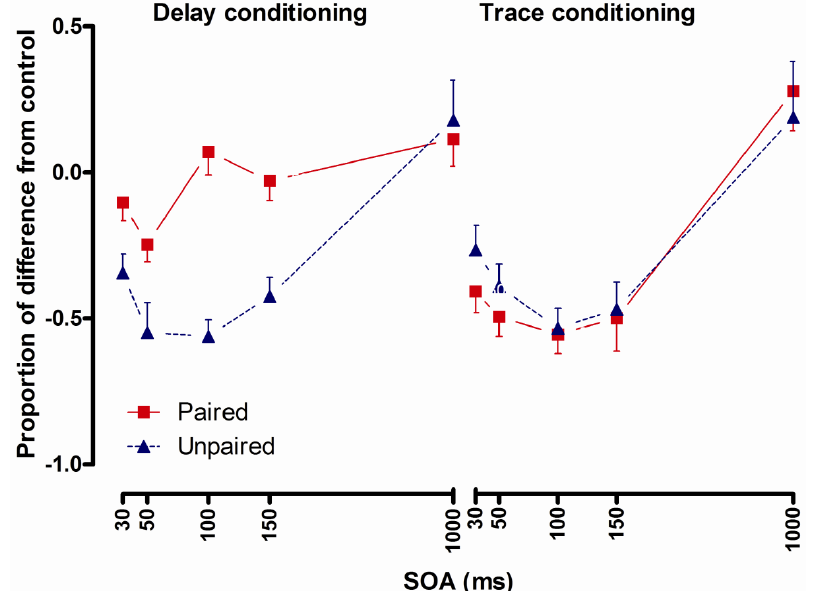
Figure 4. Startle reflexes following delay conditioning (left panel) and trace conditioning (right panel) expressed as proportion of difference from control in the paired and the unpaired group across stimulus onset asynchronies (SOA). Error bars represent 1 standard error of the